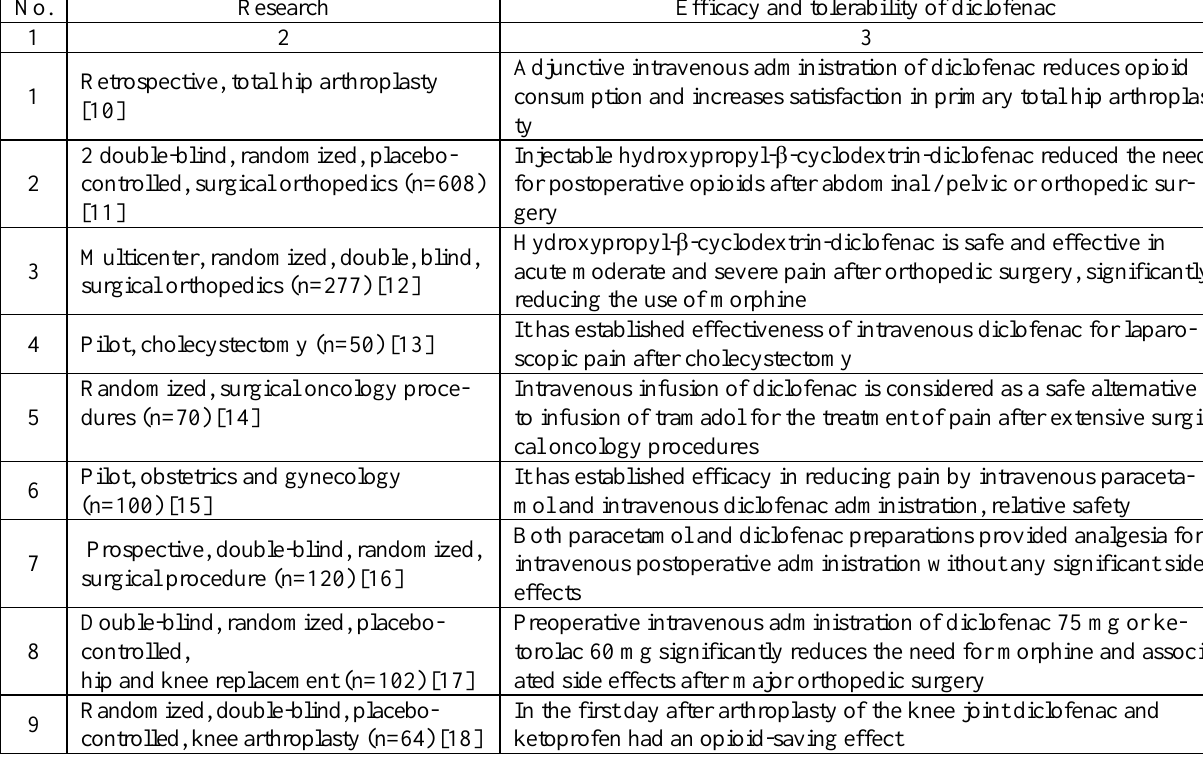
Efficacy and tolerability of diclofenac for the prevention of postoperative pain during intravenous